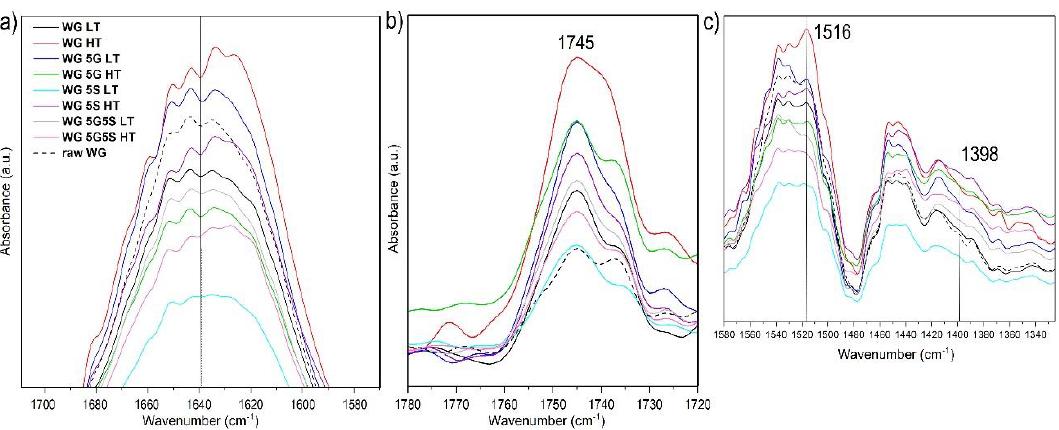
Figure 7. FTIR of the amide I region ( a ), the carbonyl region ( b ) and 1550–1340 cm −1 region ( c ) for the different samples.